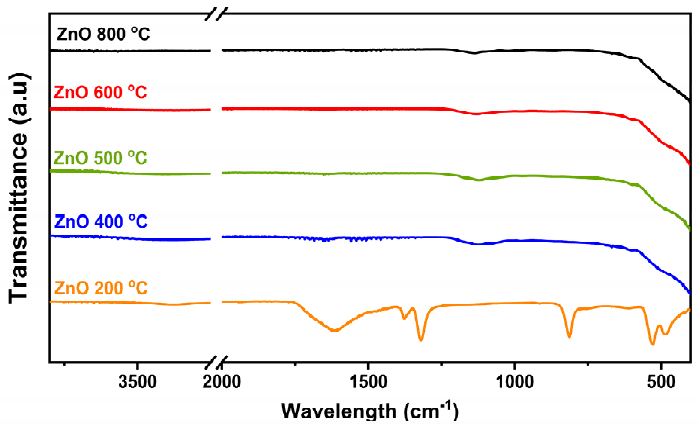
Figure 3. Infrared wave absorption spectrum of ZnO samples.